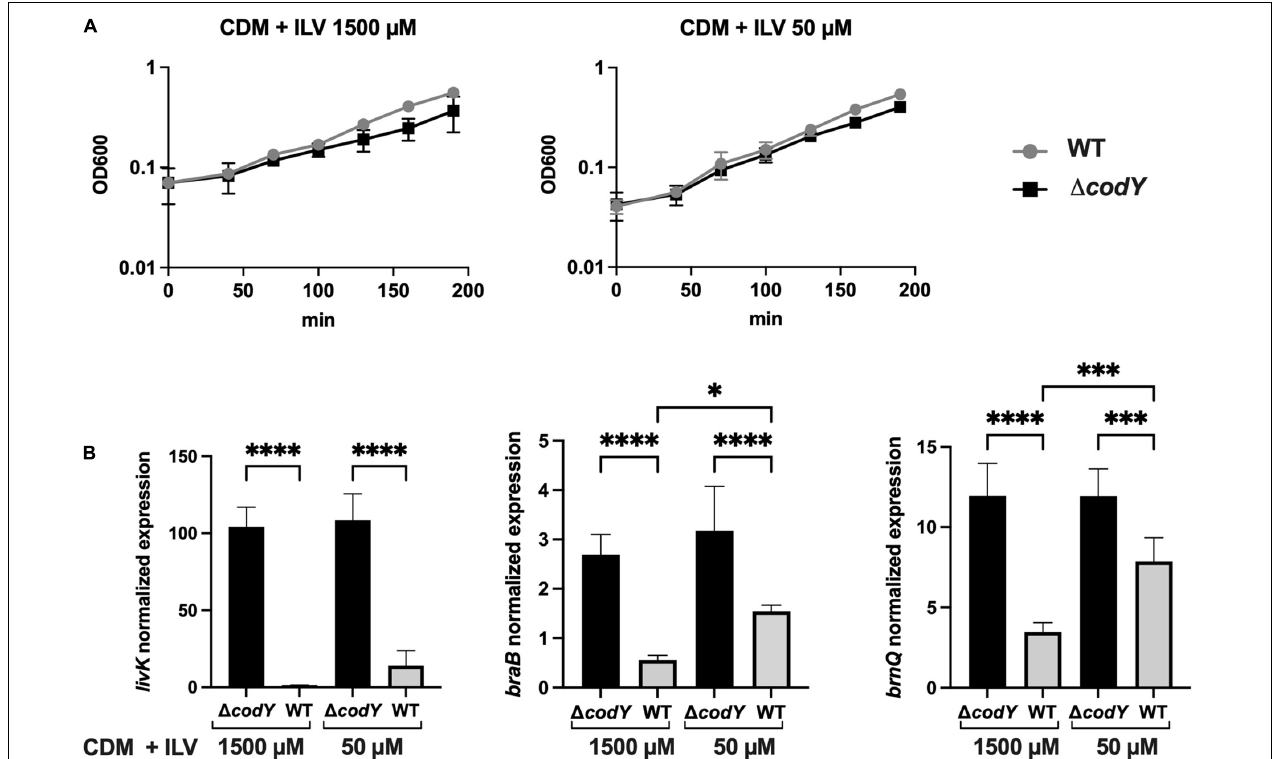
FIGURE 6 | CodY activity is dependent on branched-chain amino acids availability. (A) Growth of the WT (gray) and (cid:49) codY mutant (black) in CDM supplemented with high (1500 µ M) and low (50 µ M) ILV concentrations. Reported data are the average ± SD of two independent experiments. (B) Expression analysis by qRT-PCR of the genes livK , braB , and brnQ in the WT and (cid:49) codY mutant grown under high and low ILV concentrations. Gene expression is normalized to the expression of the housekeeping gyrA gene. Asterisks denote statistically significant differences as assessed by One-way ANOVA analysis * p < 0.05, *** p < 0.001, **** p <